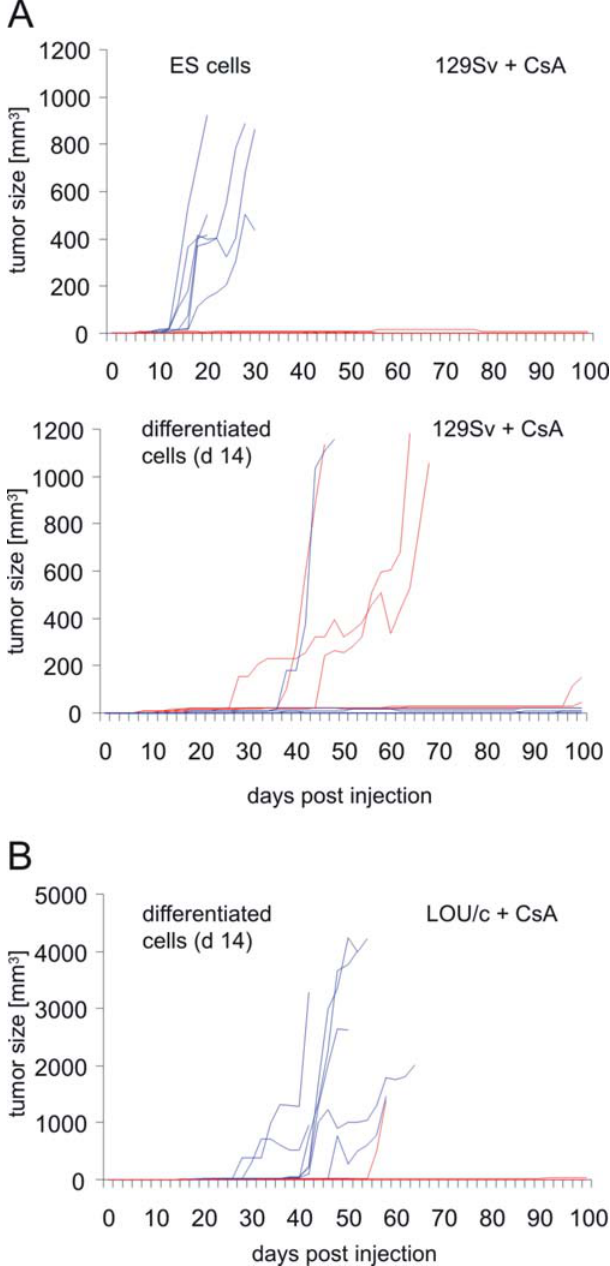
Figure 5. Tumor growth in CsA-treated 129Sv mice and LOU/c rats after injection of ES cells or invitro differentiated cells. (A) 1 6 10 6 ES cells or in vitro differentiated cells were injected subcutane- ously at day 0 into syngeneic 129Sv mice (for the numbers of animals see Table 2) which were treated daily with CsA (10 mg/kg body weight). The tumor size was recorded every second day until day 100 using linear calipers. The growth of tumors in individual mice is shown. Tumor growth in female hosts is indicated by red lines and male hosts by blue lines. (B) 1 6 10 6 cells differentiated in vitro for 14 days were injected subcutaneously into LOU/c rats (n=18) which were treated daily with CsA (10 mg/kg body weight). The tumor size was recorded every second day until day 100 using linear calipers. The growth of tumors in individual rats is shown. Tumor growth in female hosts is indicated by red and in male hosts by blue lines. One tumor in a female rat was not progressive and remained very small until the end of the experiment. In two male rats a tumor regression